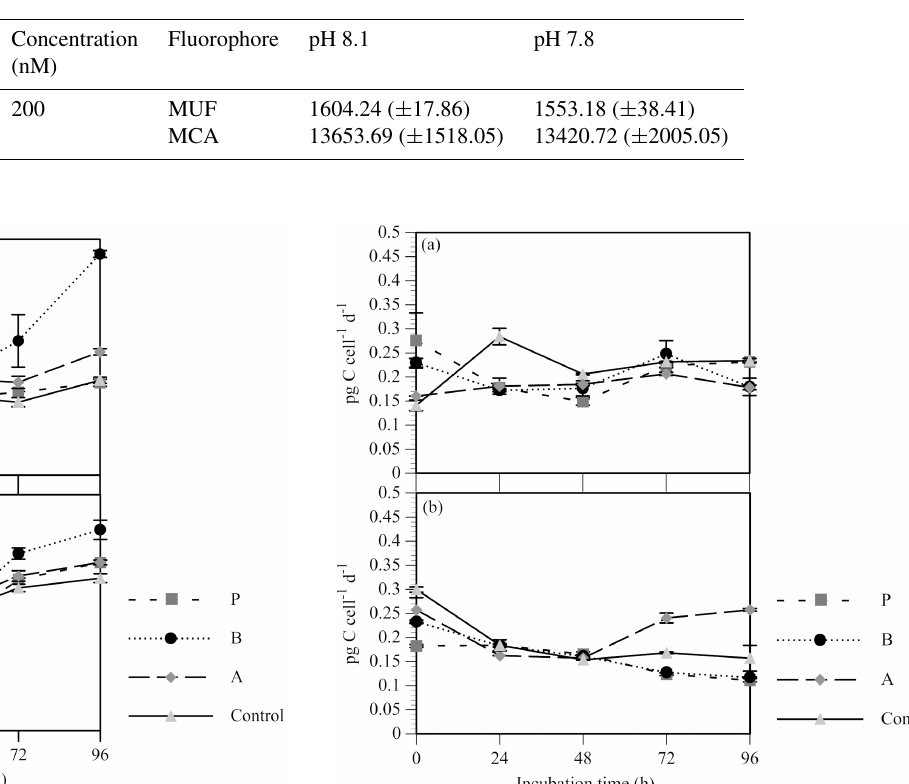
Table 1. Mean fluorophore fluorescence at pH 8.1 ad 7.8 (RFU, n = 3, ± SD).